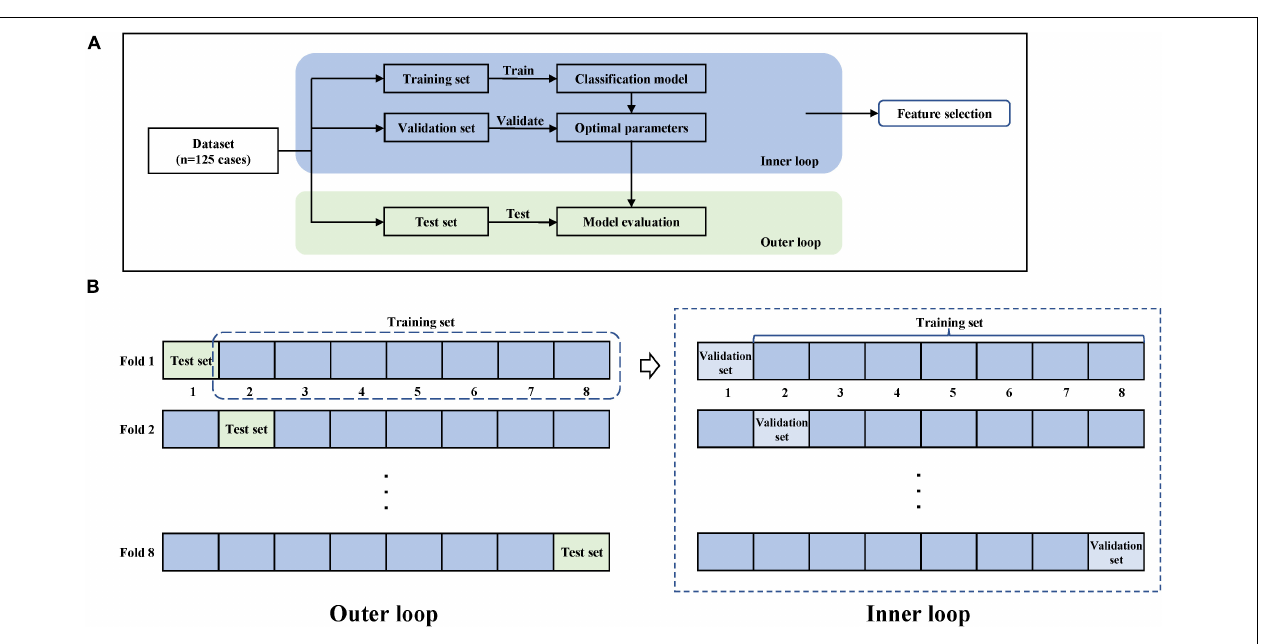
FIGURE 5 | Model training and nested cross-validation. (A) General overview. (B) 8-fold